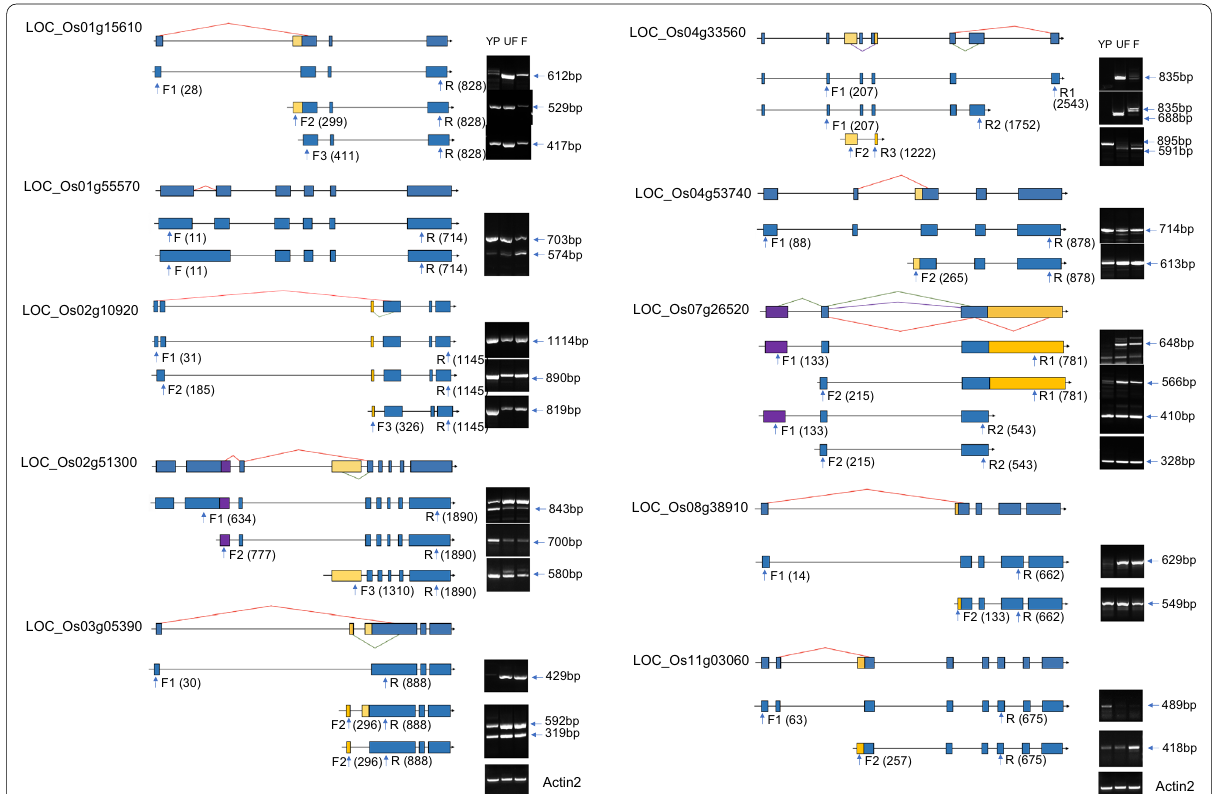
Fig. 2 Validation of different alternative splicing (AS) events by RT-PCR. Fourteen AS isoforms were selected to check each isoform in RT-PCR and eleven AS were detectable at the mRNA level either with changed transcript levels or new isoforms. The primer of each hand used for variation were arrowed and the primer position numbered from transcription start sites ATG were indicated. The product size of each alternative isoform was showed. The cycles of RT-PCR were showed in Additional file 2: Table S3. The dRNA-seq data of the above DAS events were showed in Additional file 1: Figure S3. Actin2 was used as the inner